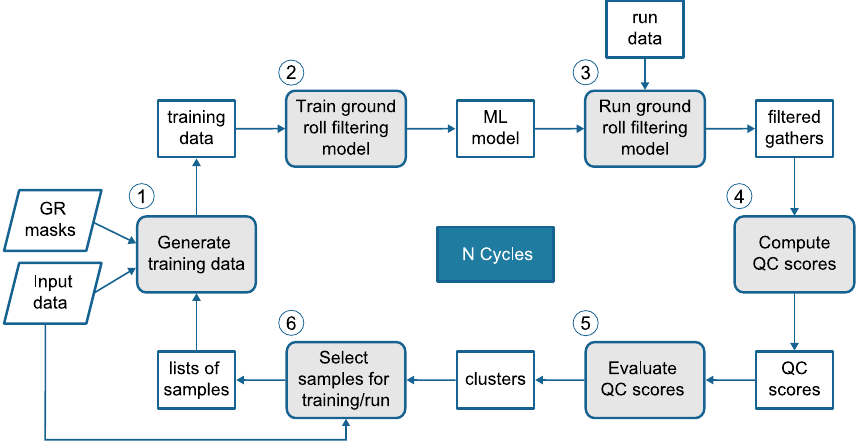
Figure 3. NS use case. The numbers show the order of execution and the gray blocks highlight the sequence of operations that composes the geocycle. Ground roll (GR) detection masks are inputs to this